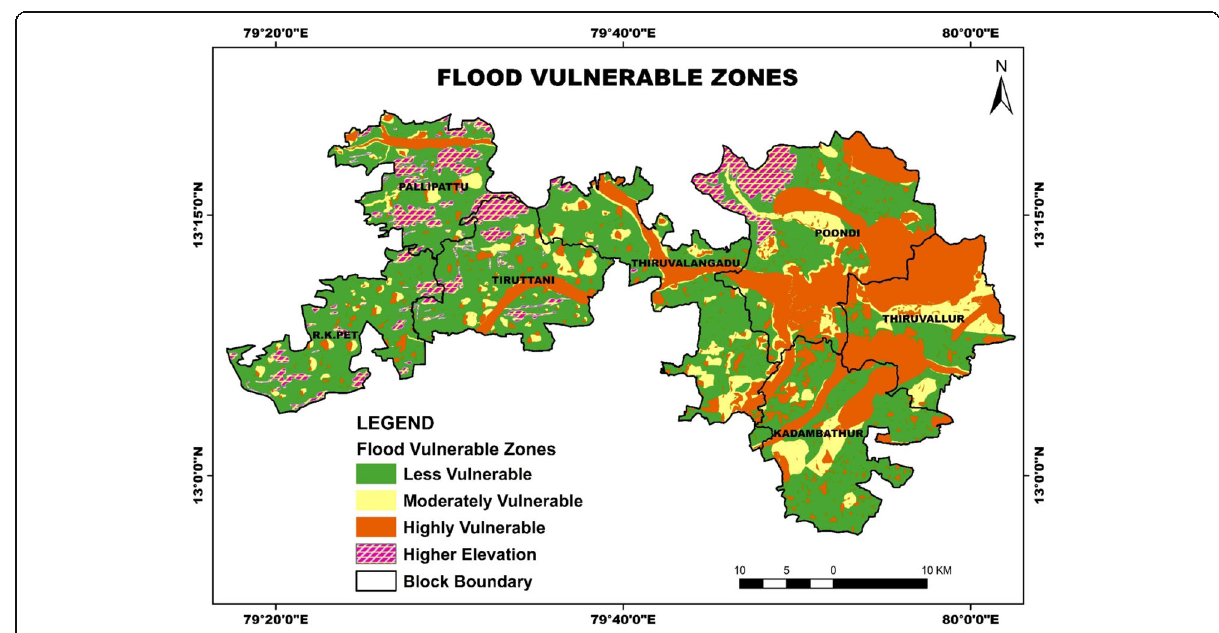
Fig. 12 Block-wise flood vulnerable zonation map